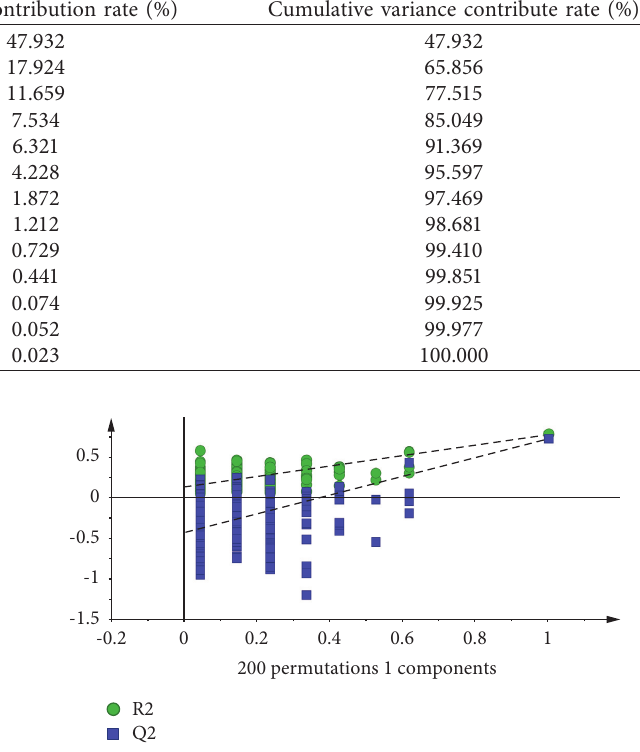
Figure 5: Permutation test plots of OPLS-DA